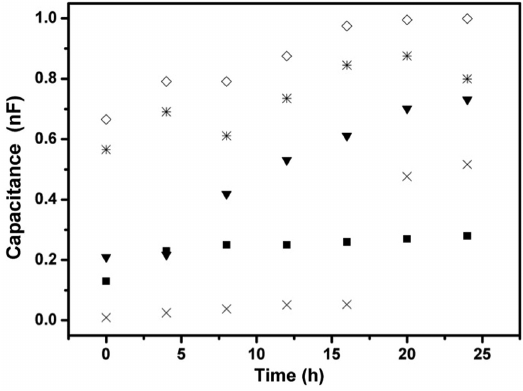
Figure 7. Capacitance values obtained during 24h immersion in saline solution for: (◊) uncoated metal; samples coated with epoxy: (▼) without anticorrosive additives, (■) +0.2%, (×) +0.5% and (*) +1.0% w/w ZnO/PPy.